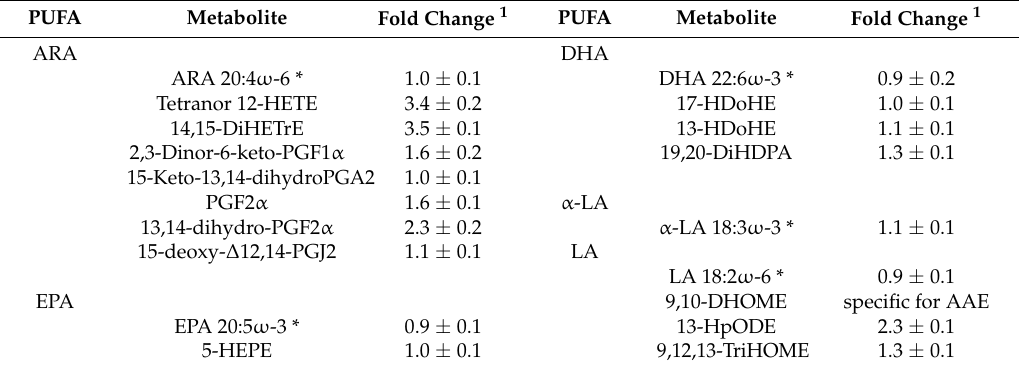
Figure 1. Topical treatment with AAE alters PUFAs metabolome in murine HFs. Schematic cartoon depicting some of the metabolic reactions positively affected by AAE in murine HFs. Green arrowheads indicate reactions stimulated by AAE. Green dots indicate metabolites, whose intracellular concentration resulted increased by AAE. (COX cyclooxygenase; LOX, lipoxygenase; CYP, cytochrome P450; sEH, soluble epoxide hydroxylase; n.e. non enzymatic. The abbreviations of PUFA metabolites as well as their full IUPAC name are shown in Table S1). Table 1. Fold induction for the indicated metabolites measured upon in vivo treatment with